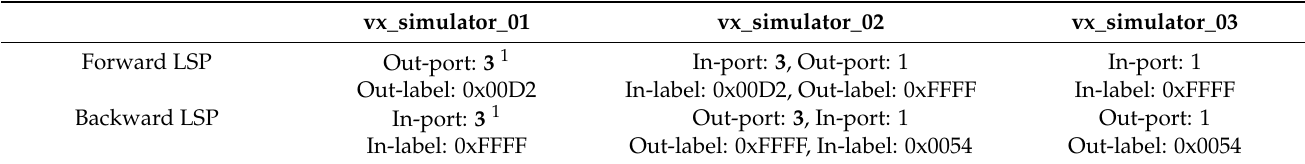
Table 5. The bi-directional label switching path under QoS requirements and the circumstances of a bi-directional link between node vx_simulator_01, node vx_simulator_02, and node vx_simulator_03 in the semi-physical